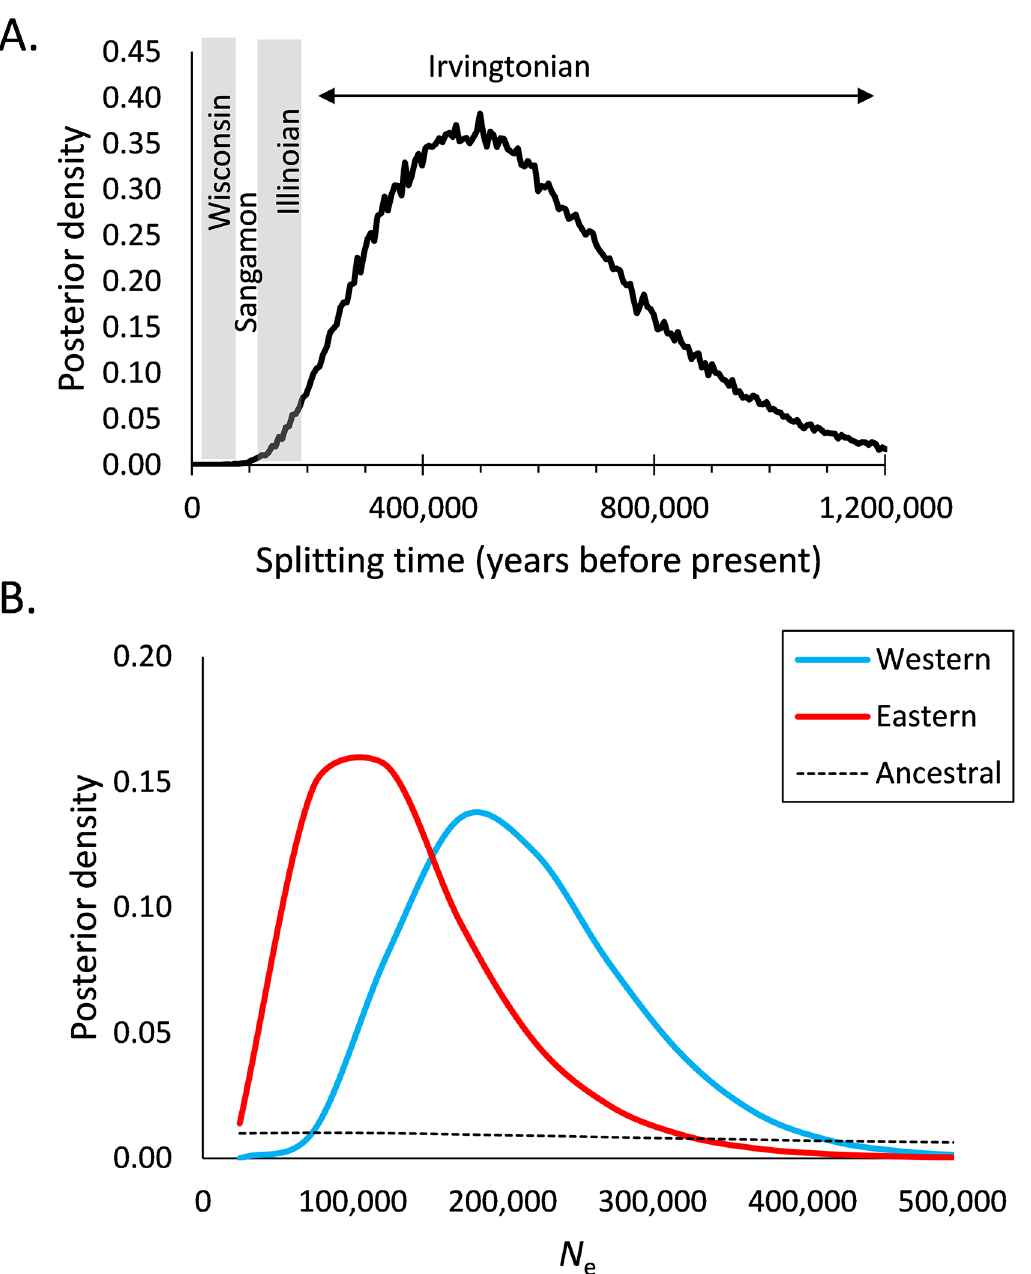
Fig 4. Coalescent analysis of mitochondrial cytochrome b sequences of 180 Urocyon in IMa2, providing (A) an estimate of splitting time separating eastern and western Urocyon and (B) estimates of effective population sizes ( N e ) of western, eastern, and ancestral Urocyon spp. Comparison of Fu ’ s F statistics to those simulated under constant-population size models S (based on the entire concatenated sequences) indicated no statistically significant evidence of = 5.07, P = 0.96) or the (south)west- recent population expansions in either the (south)eastern ( F S ern ( F = -4.07, P = 0.14) population, consistent with long-term stability (or population declines) S in both portions of the continent. A Bayesian skyline plot using the western sample, however, indicated a gradual increase in abundance beginning around 70,000 YBP (35,000 generations),